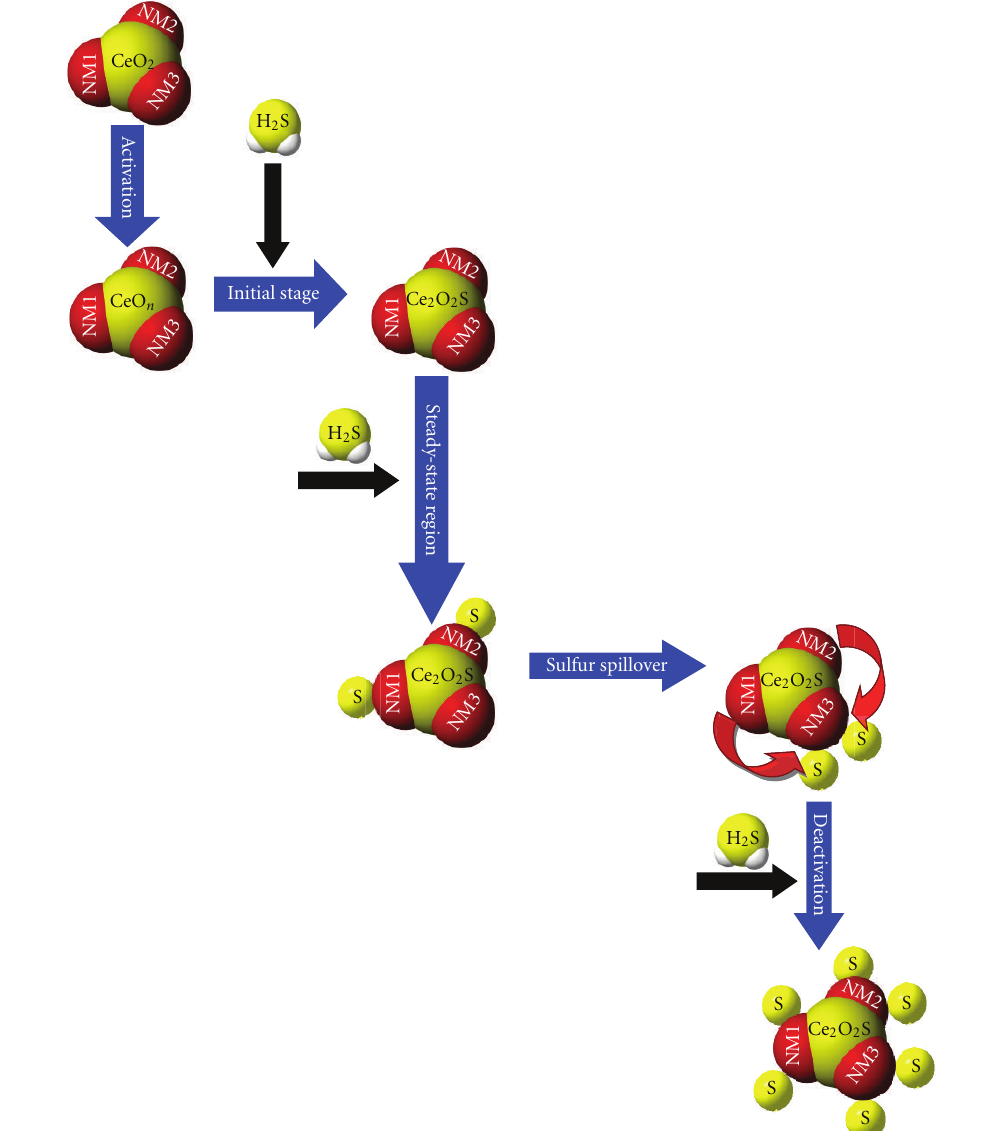
Figure 10: Phenomenological mechanism operative in the tri-metal-supported